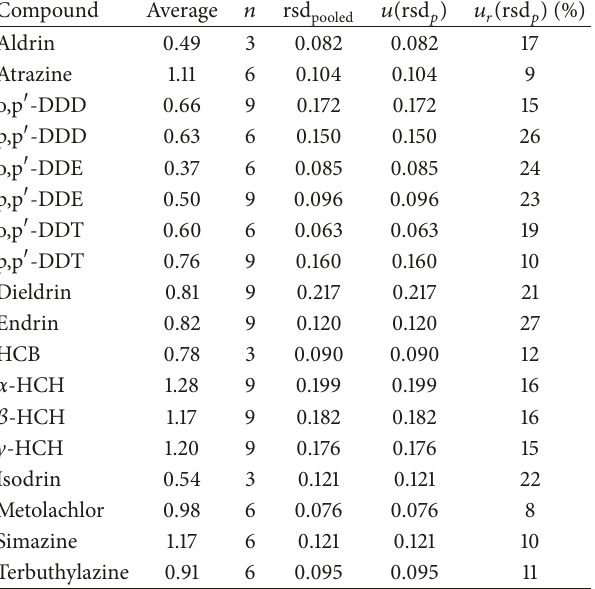
Table 5: Results of uncertainty associated with recovery of selected pesticides in water and sediment samples (n.a.: nonanalyzed).